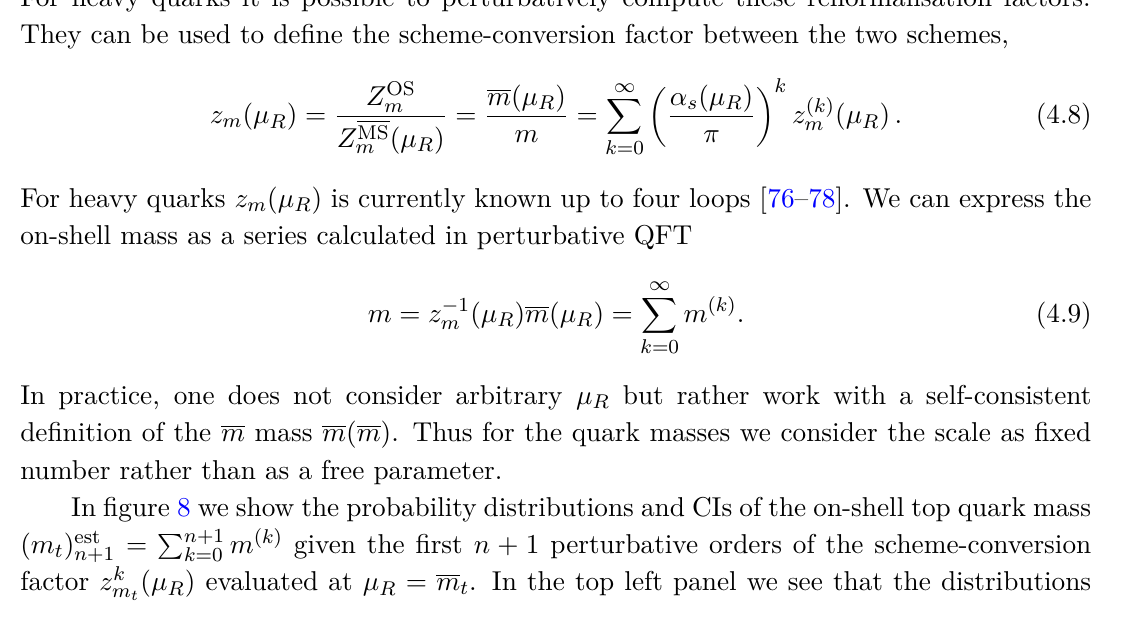
Figure 8 . Top left panel: the probability distribution from the abc -model for the on-shell top quark mass ( m ) est evaluated at µ = m and for different values of n . Top right panel: the same t R t n +1 distributions normalised to the exact N n +1 LO correction. Bottom left panel: the median (plus), 68% CI (errorbox) and 95% CI (errorbar) for the posterior of ( m ) est , computed from the abc t n +1 (blue) and geometric (red) models using information on the previous orders. The exact values of ( m ) are shown as black circles. Bottom right panel: CIs scaled to the exact N n +1 LO correction. t n For heavy quarks it is possible to perturbatively compute these renormalisation